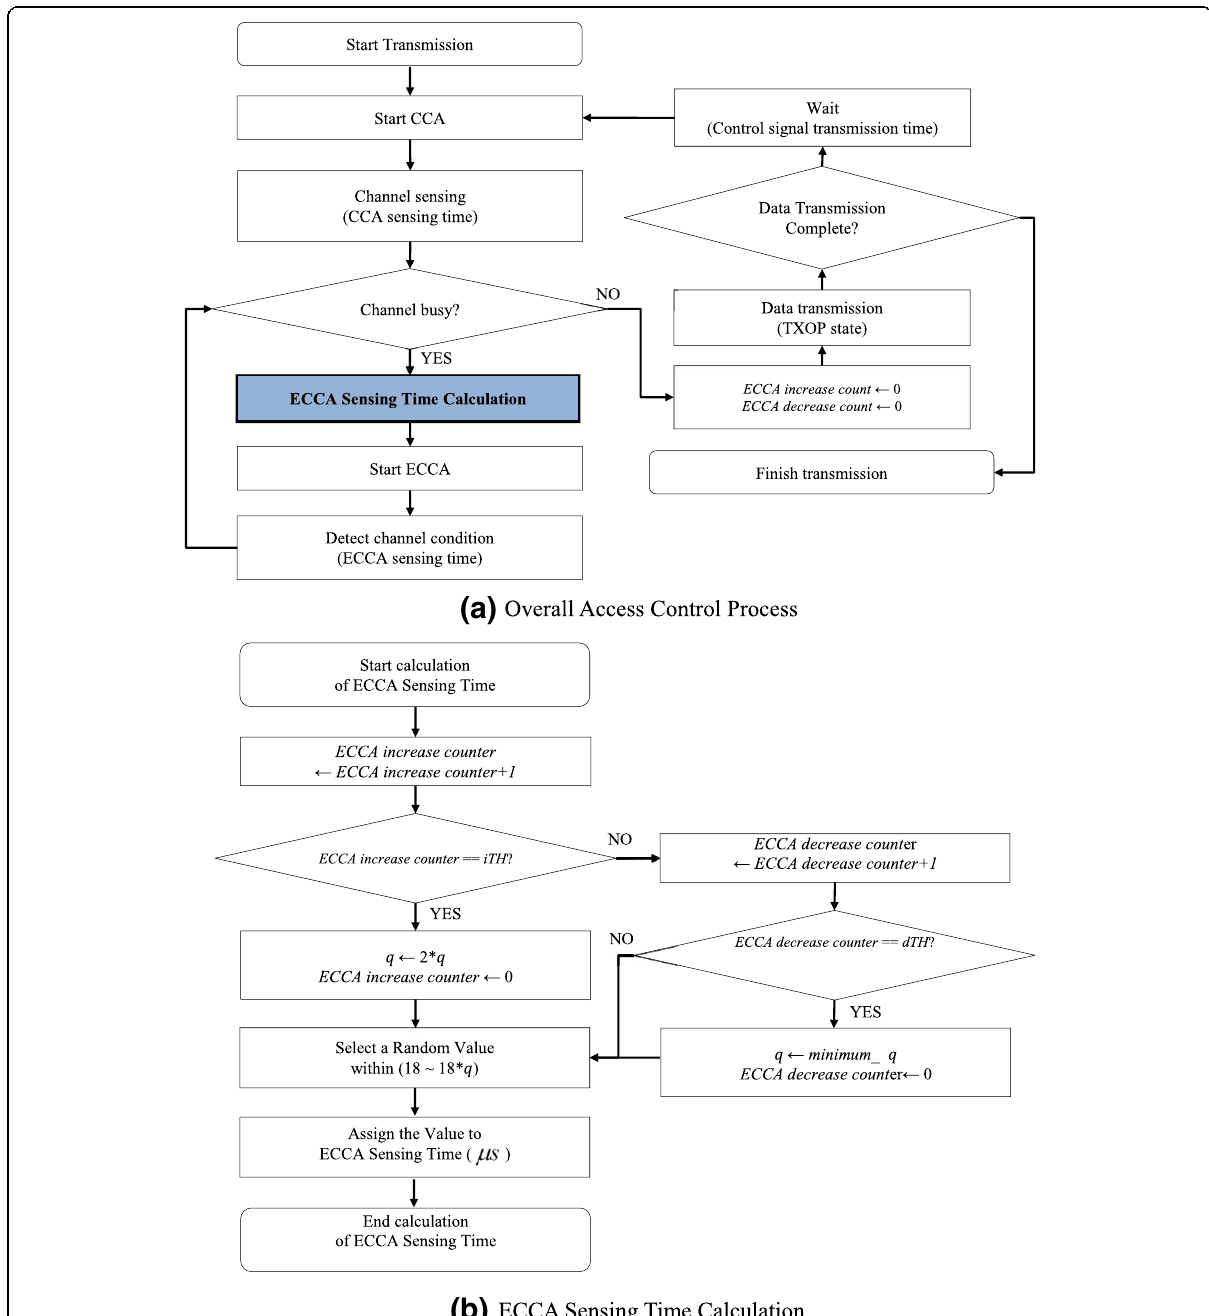
Fig. 3 Flow chart for access Control. a Overall access control process. b ECCA sensing time